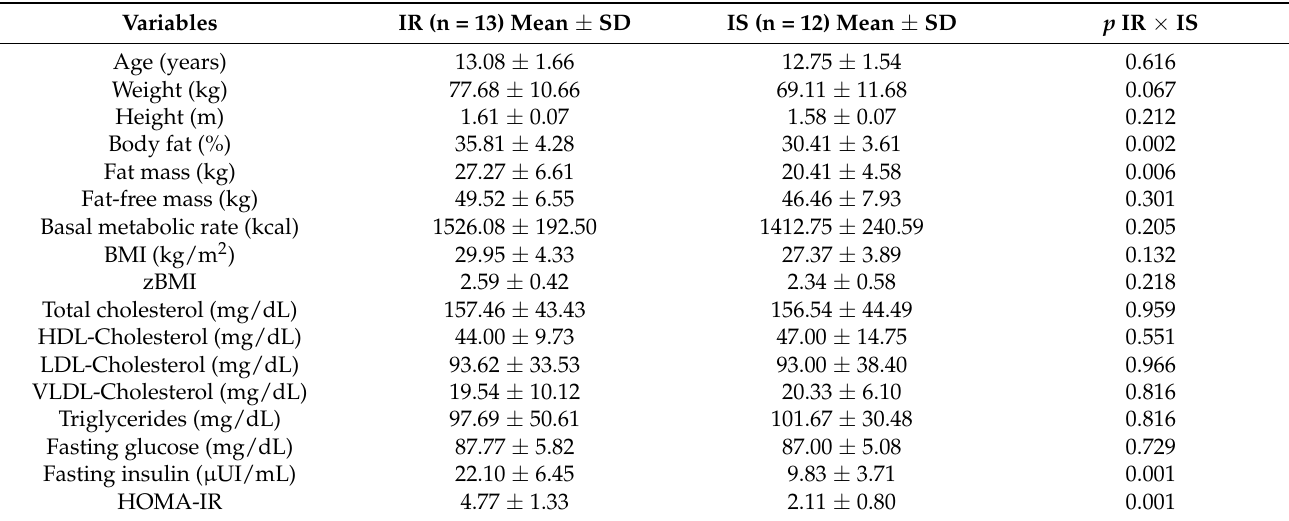
Table 1. Baseline data of groups insulin-resistant (IR) and insulin-sensitive (IS).